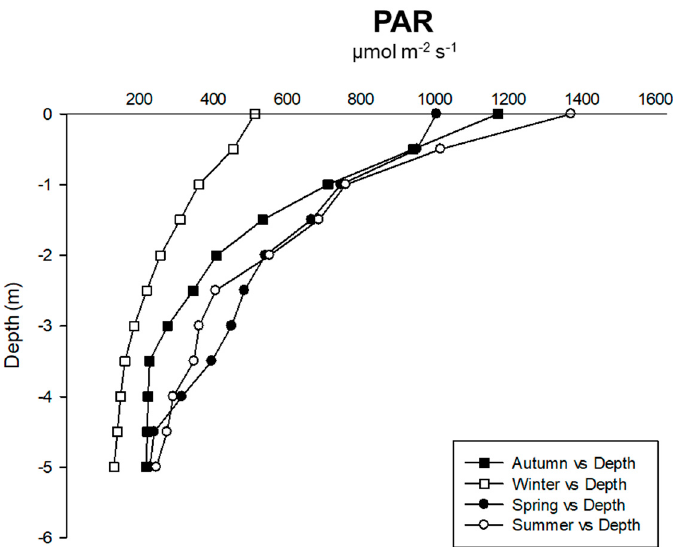
Figure 2. PAR diffuse attenuation coefficient (K dPAR ) downwards the water column, measured at the monitoring site in Central Chile from March 2019 to February 2020. monitoring site in Central Chile from March 2019 to February 2020. Table 1. Abiotic parameters: Temperature (T °C), pH, salinity and PAR diffuse attenuation coeffi- cients (K dPAR express in m − 1 ) measured in the water column in the Cochoa Beach (Reñaca—Chile), on a monthly basis from March 2019 to February 2020 along the autumn, winter, spring, and summer seasonal times. T °C pH Salinity K dPAR Autumn 13.57 ± 1.22 7.91 ± 0.15 33.91 ± 1.13 0.360 Winter 12.25 ± 0.04 7.90 ± 0.09 31.95 ± 0.42 0.288 Spring 13.53 ± 0.70 7.93 ± 0.01 31.74 ± 0.25